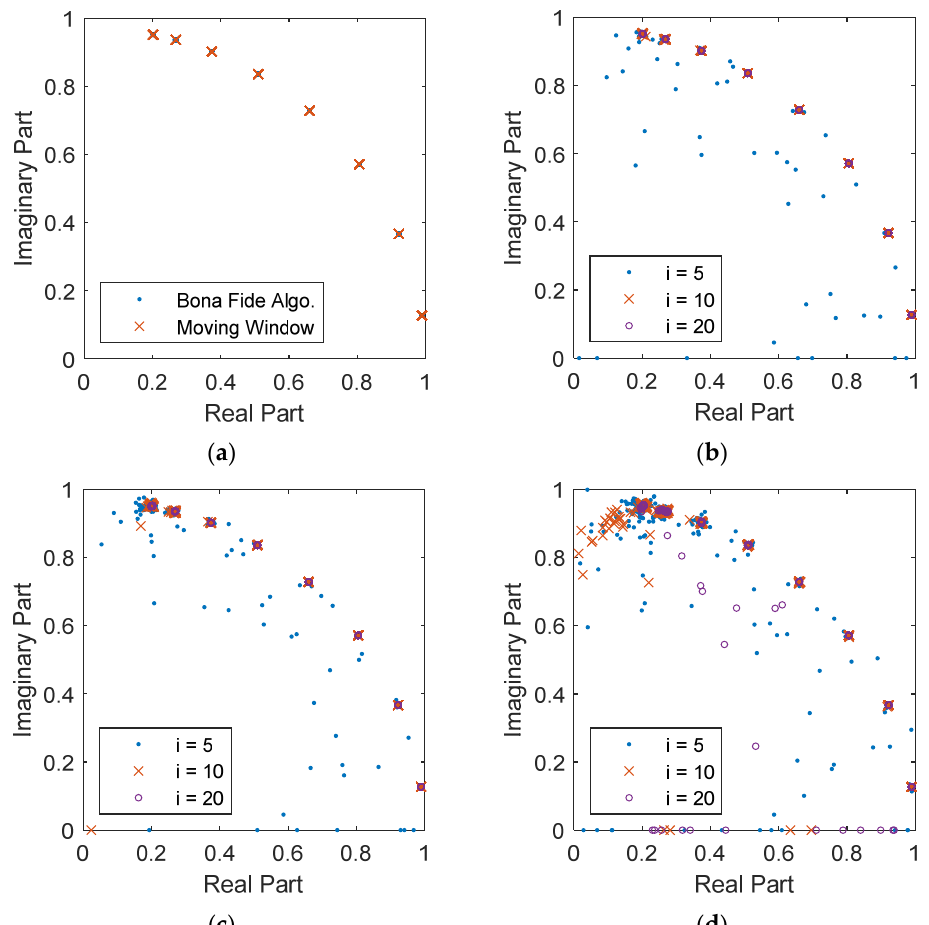
Figure 5. The identified system poles under different levels of background noise. ( a ) noise-free ( i = 10); ( b ) low noise (SNR = 30); ( c ) medium noise (SNR = 25); ( d ) high noise (SNR = 20).